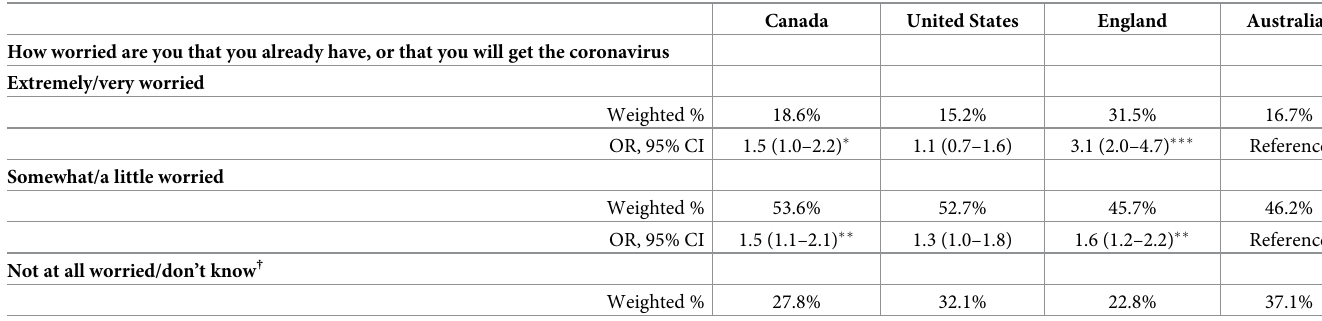
Table 7. Smokers’ worry about getting (or having had) COVID-19 by